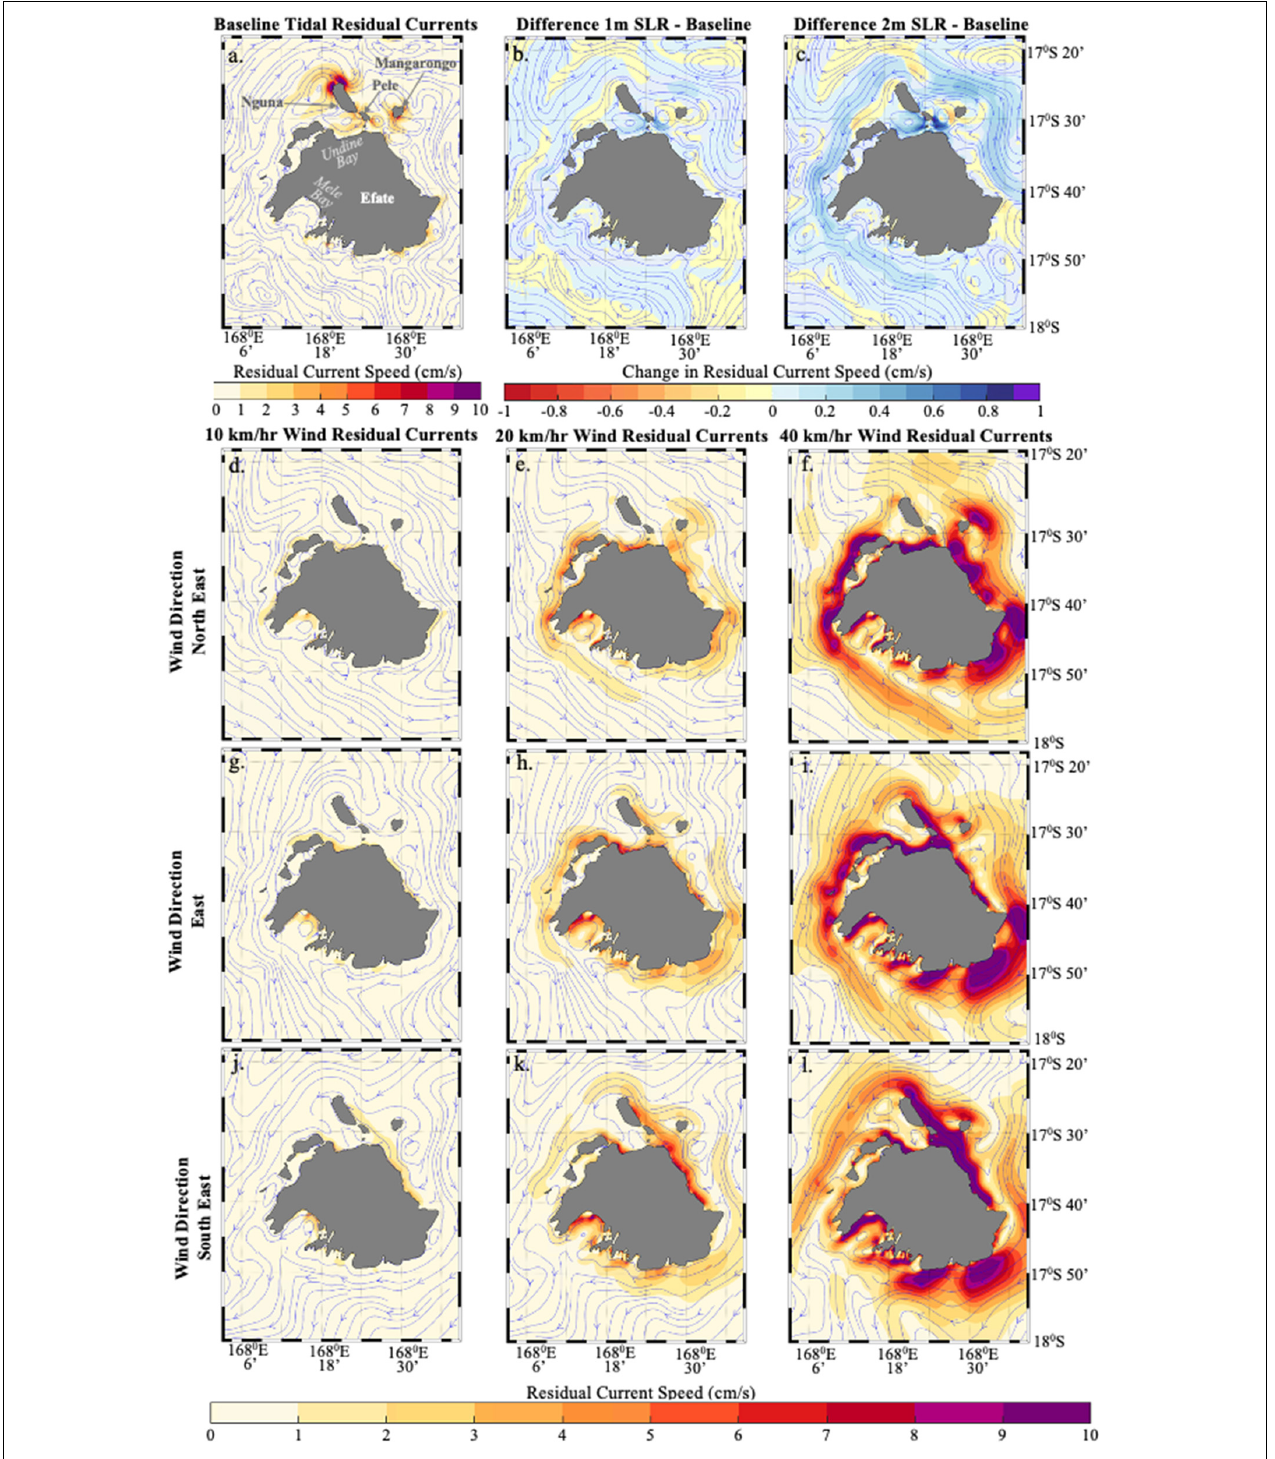
FIGURE 9 | Tidal residual current speeds, with current patterns indicated by streamlines, around Efate Island, Vanuatu (a) . Change in residual current speeds (cm/s) and patterns under 1 m SLR (b) and 2 m SLR (c) . Wind residual current speeds (cm/s) and patterns under 10 km/h (d) , 20 km/h (e) , and 40 km/h (f) northeast winds. Wind residual current speeds (cm/s) and patterns under 10 km/h (g) , 20 km/h (h) , and 40 km/h (i) east winds. Wind residual current speeds (cm/s) and patterns under 10 km/h (j) , 20 km/h (k) , and 40 km/h (l) southeast winds. Latitudes are displayed to the right of panels (c,f,i,l) . Longitude for all panels are displayed below panels (a–c,j–l)